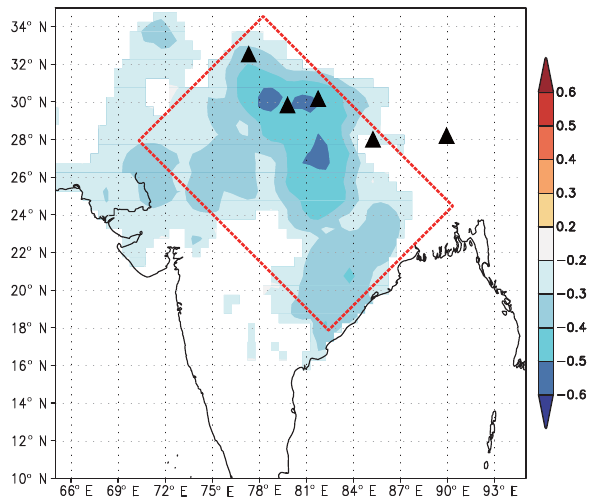
Figure 6. Spatial correlations between the H5 regional tree-ring δ 18 O record with June–September precipitation from GPCC V7 over interval from 1901 to 2008CE. Only correlations significant at the 95% level are